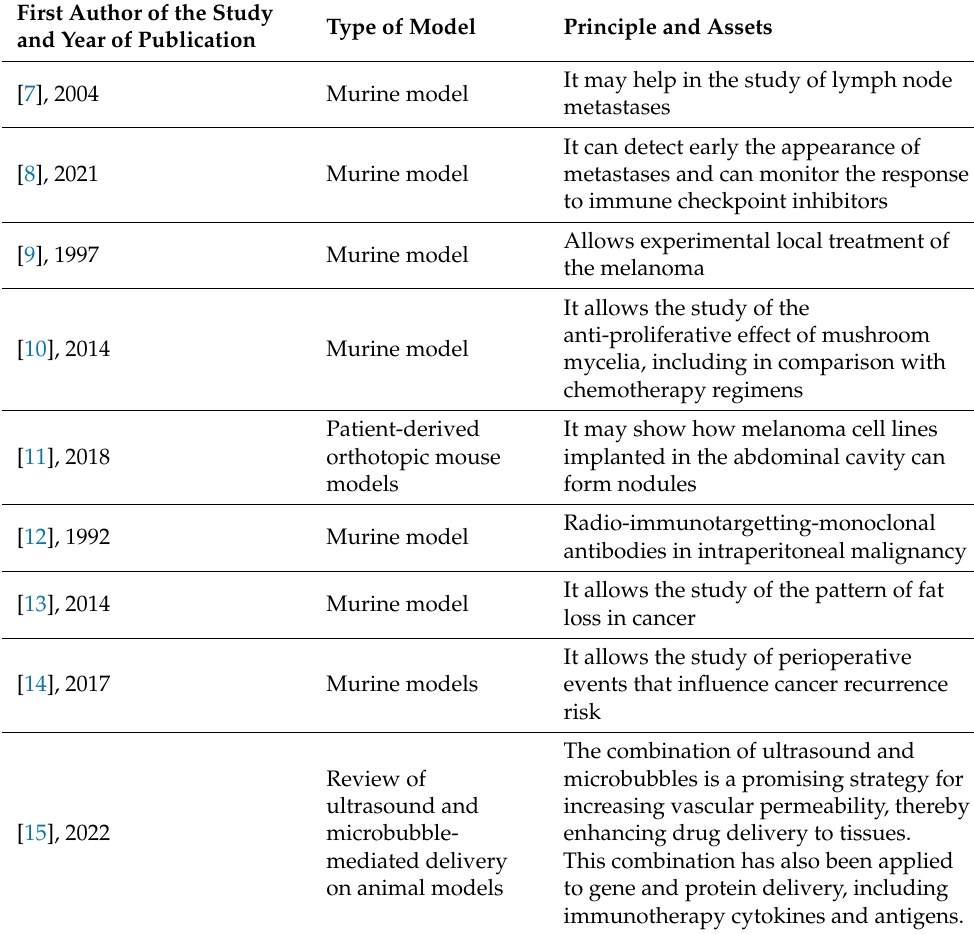
Table 2. Examples of different research illustrating various assets of the study of melanoma in animal